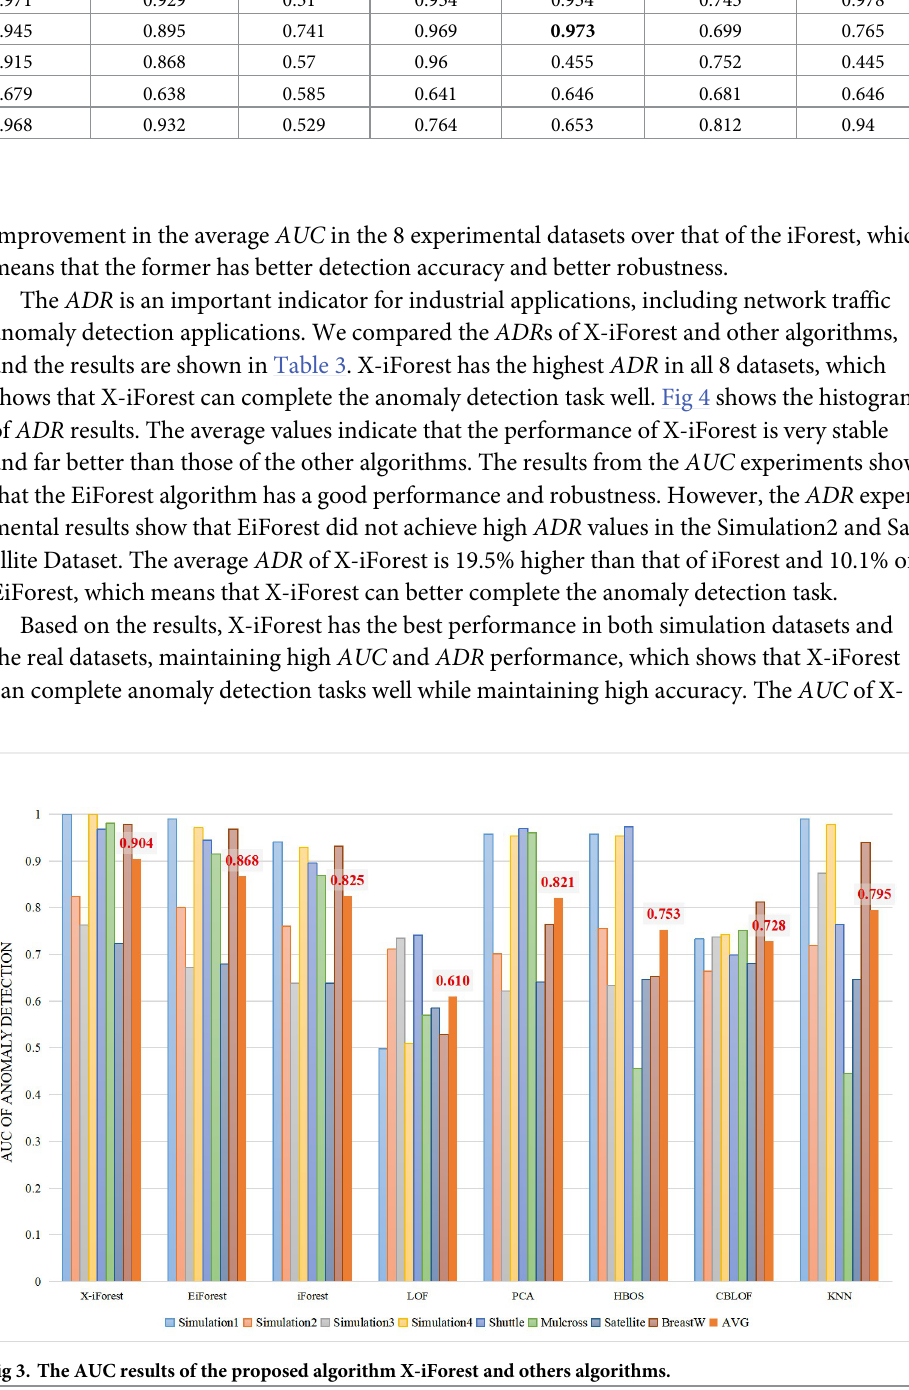
Fig 3. The AUC results of the proposed algorithm X-iForest and others algorithms.